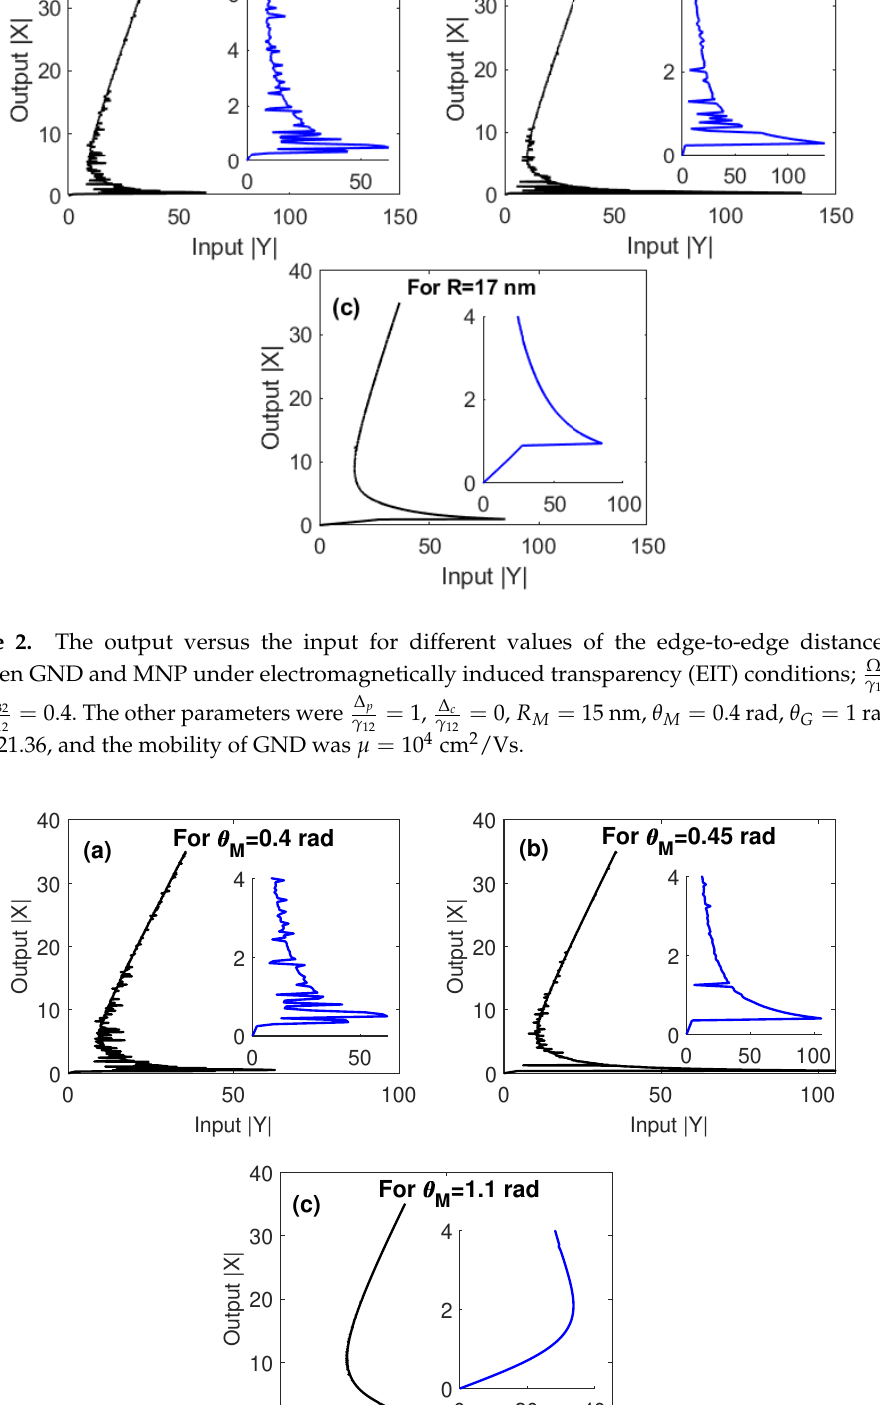
∆ p = 1, ∆ c = 0, γ 12 γ 12